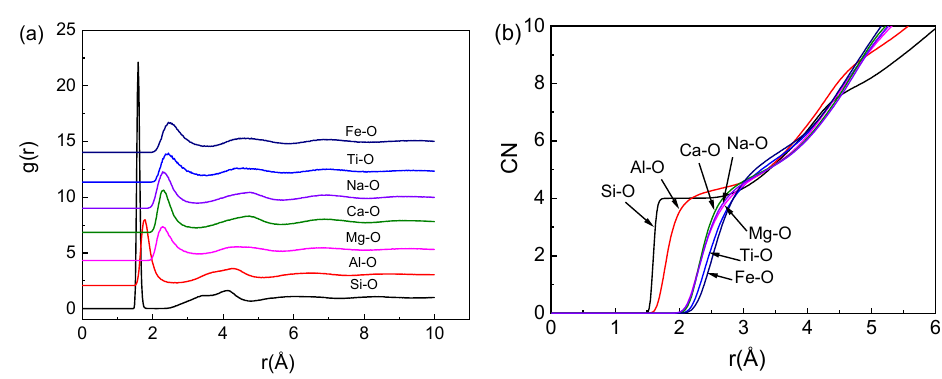
Figure 3. ( a ) PDF and ( b ) CN of sample #1 in the fused red mud system.